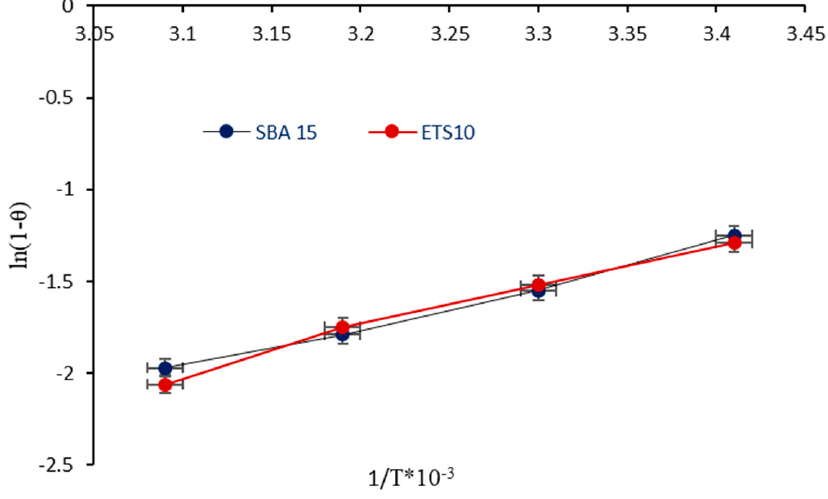
Figure 6. Plot of ln(1- θ ) vs.